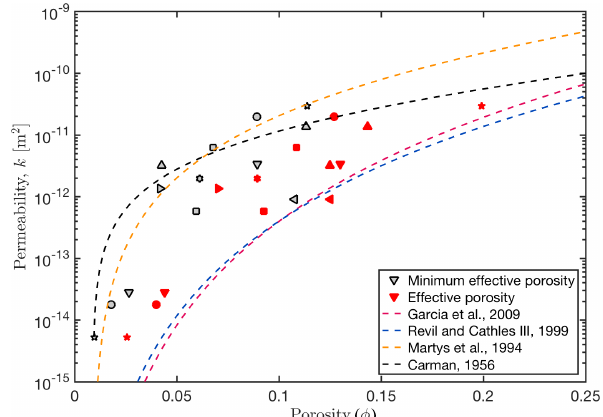
Figure A1. Measured permeability against porosity. Symbols with a grey face represent a sample using the minimum effective porosity per sample, while red symbols display a measured sample using the effective porosity. Dashed lines show several permeability parame- terizations.